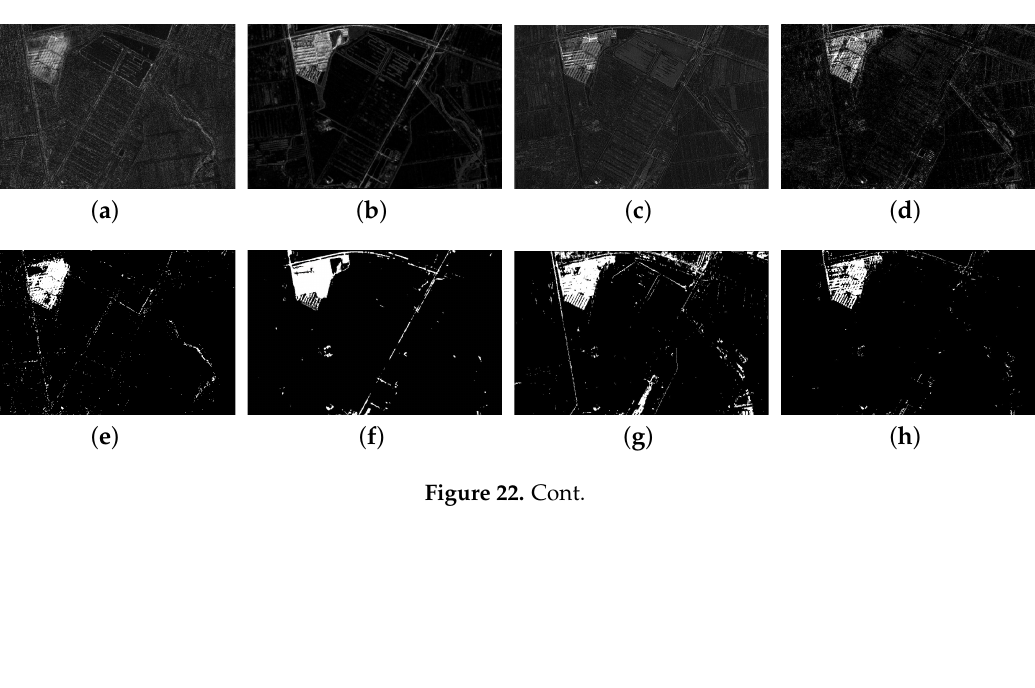
Figure 21. Classification and change detection images for the Shuguang Village dataset by PCC. ( a ) Classification image for the SAR image. ( b ) Classification image for the optical image. ( c ) Resulting image.